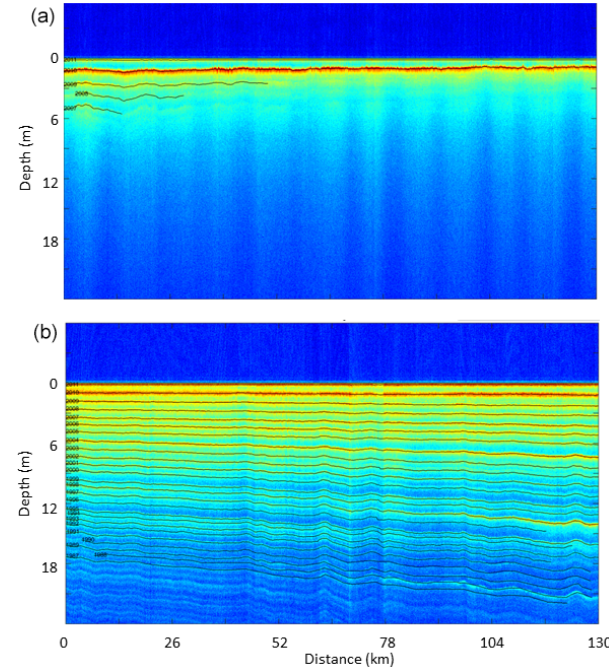
Figure 3. Example snow radar radargrams from 2011 in the percola- tion zone (top), inland from Jakobshavn Isbræ, and dry-snow zone (bottom), near the ice divide ∼ 220km south of Summit Station, showing automatically picked layers (black) resulting from the layer picking algorithm before any manual adjustments. Indexing by year is shown at the left end of each picked layer. Snow radar data frames represented are 20110422_01_218 to 20110422_01_244 (top) and 20110426_03_155 to 20110426_03_180 (bottom) (Leuschen, 2014). Locations of the radargrams are shown by the red lines in Fig.